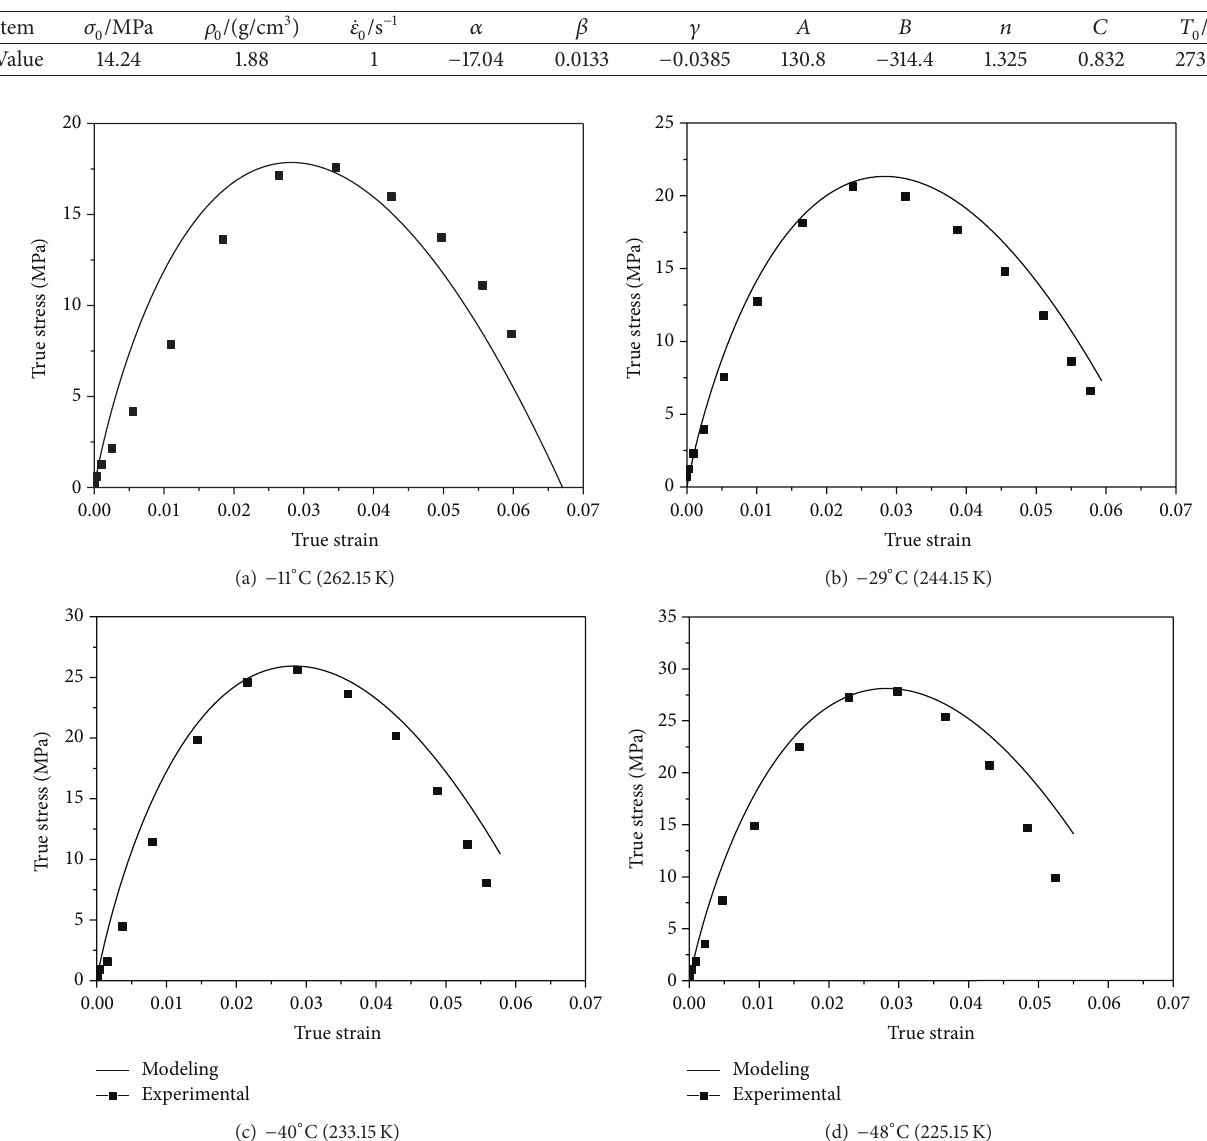
Table 2: Parameters values of the constitutive model.